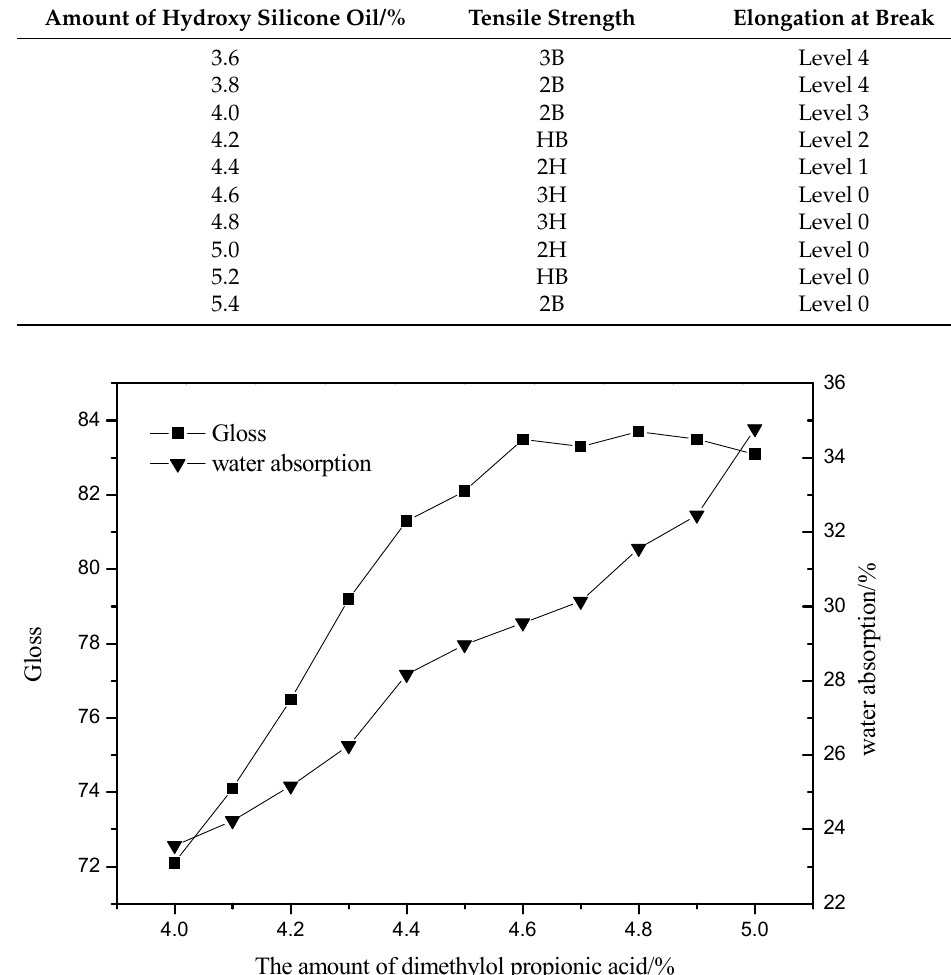
Figure 8. Effect of dimethylol propionic acid amount of gloss and water absorption. Table 2. Effect of dimethylol propionic acid content on the hardness and adhesion.